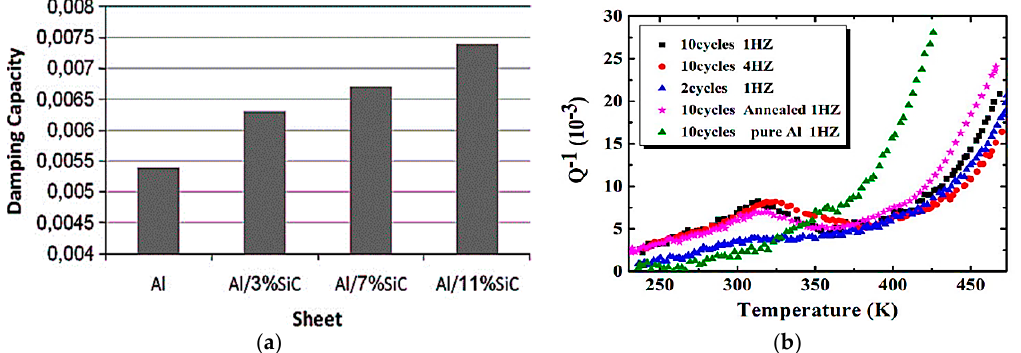
Figure 17. ( a ) First mode damping capacity of sheets with di ff erent percent of reinforcing agent [120]. ( b ) Damping capacity of Al / LLZNO p composites at di ff erent temperatures and ARB cycles